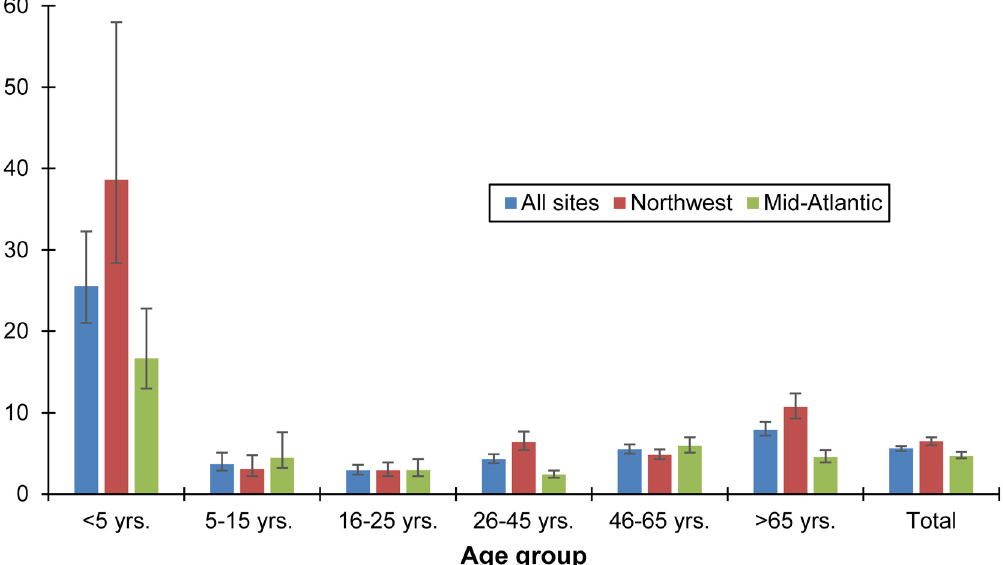
Fig 4. Estimated incidence of norovirus AGE among outpatients in Kaiser Permanente Northwest and Mid-Atlantic Health Plans, by age group, 2012 – 2013.